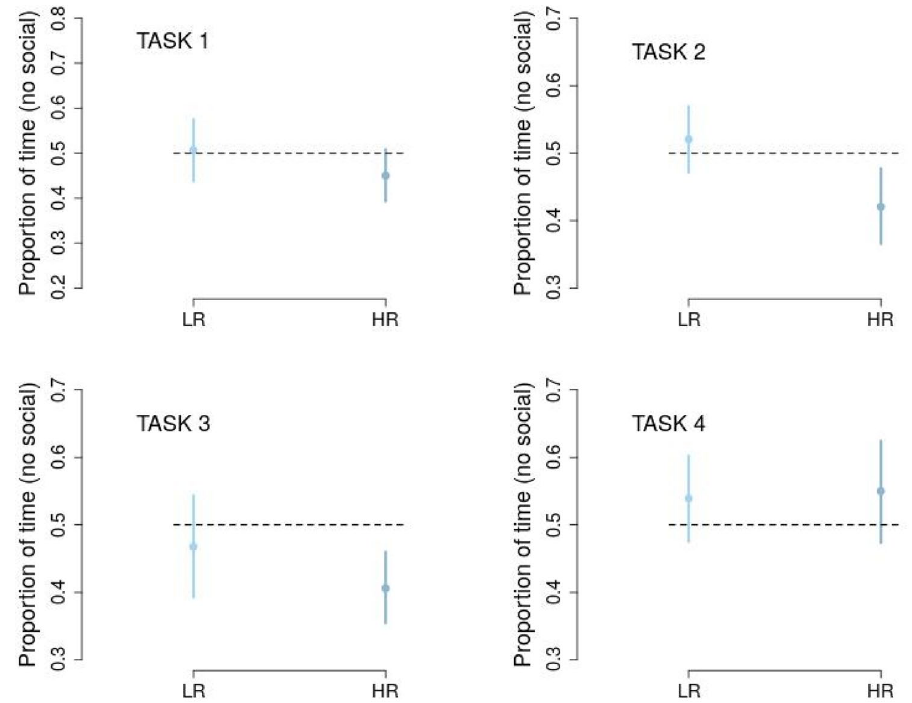
Figure 4. Mean proportion of time fixation and the confidence intervals in each of the four tasks. Mean proportions were calculated on the basis of the beta coefficients of the four linear models (Table 2). The null hypothesis (H 0 = mean proportions 0.5) is rejected if the confidence interval does not overlap with the chance level (dashed lines). Task 1: Inverted vs. upright face-like pattern. Task 2: Averted vs. direct eye-gaze. Task 3: Random motion vs. biological motion pattern. Task 4: Rigid motion vs. biological motion pattern.